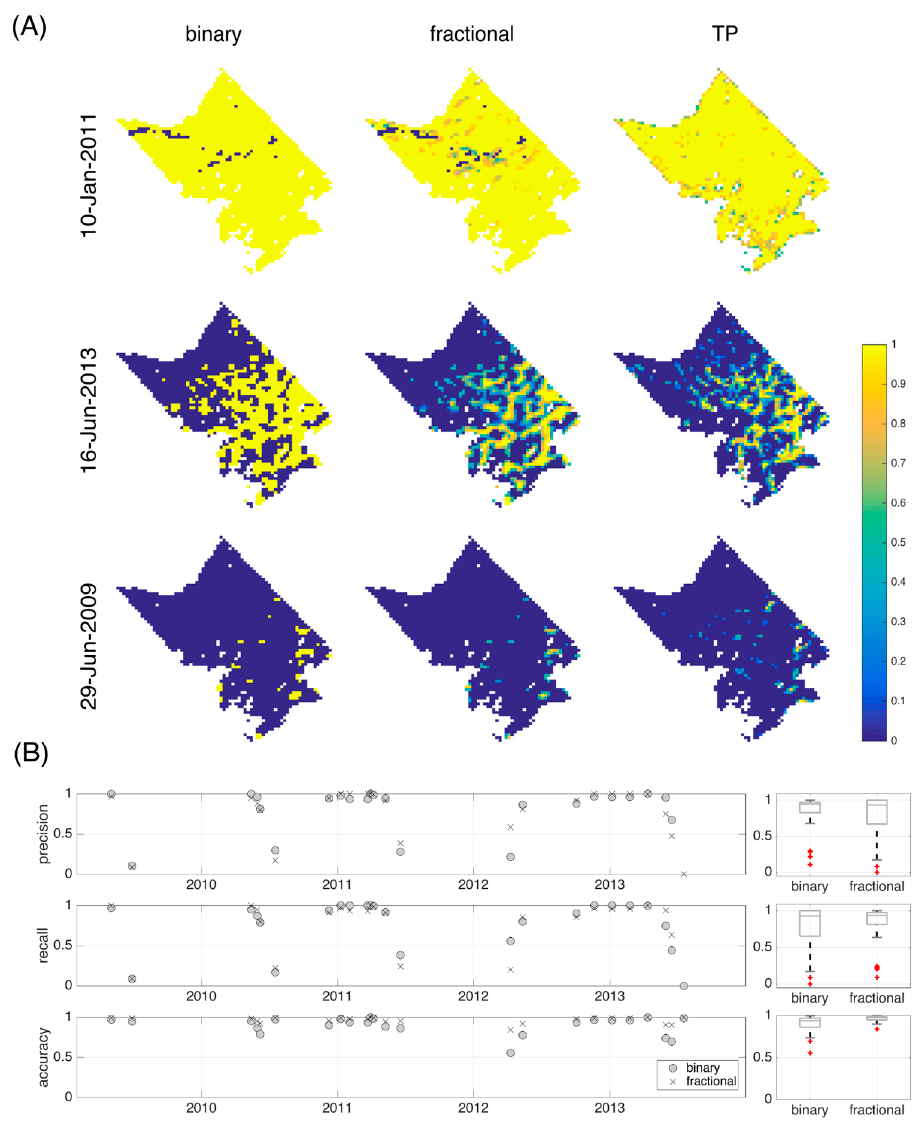
Figure 5. ( A ) Selected examples of different stages during the snow season: accumulation—complete cover (10 January 2011), beginning of the spring melting (16 June 2013) and end of the melting (29 June 2009), using the Landsat (binary and fractional) methodologies and TP at the control area. ( B ) Evolution of the three metrics (precision, recall and accuracy) used during the validation period (2009–2013) for both methodologies (right); distribution function (boxplot, the central line and the upper and lower edges of the box represent the median, 75th and 25th percentiles respectively; the black whiskers extend to the extreme values considered in the analysis; and the red crosses are the outliers) of each metric for each method (left).